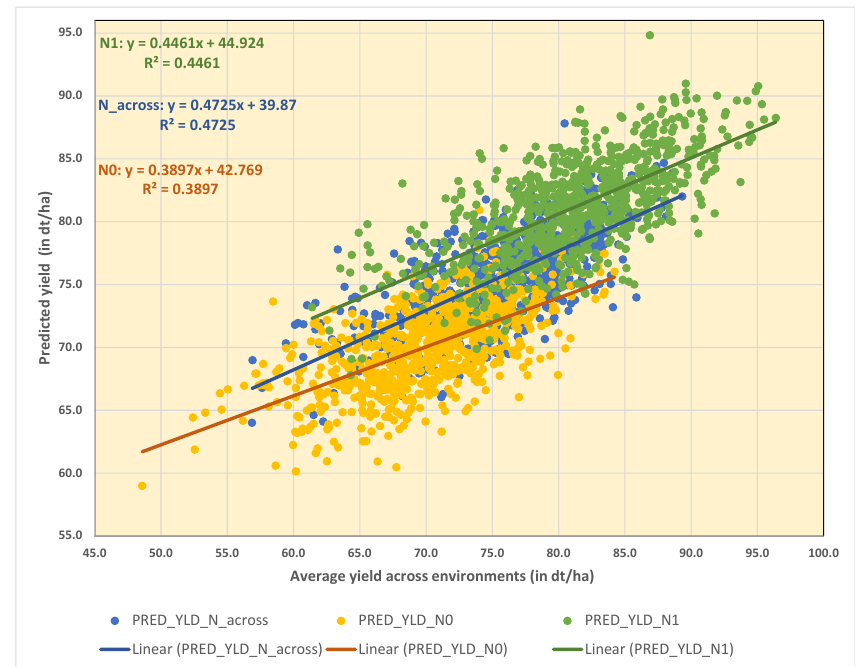
Figure 4. Multiple linear regression plot of predicted yield by actual yield averaged across N treat- ments and within N0 and N1 environments, respectively. The stepwise regression procedure HPREG selected 9-10 informative QTL alleles and 3 informative quantitative traits for yield predic- tion .